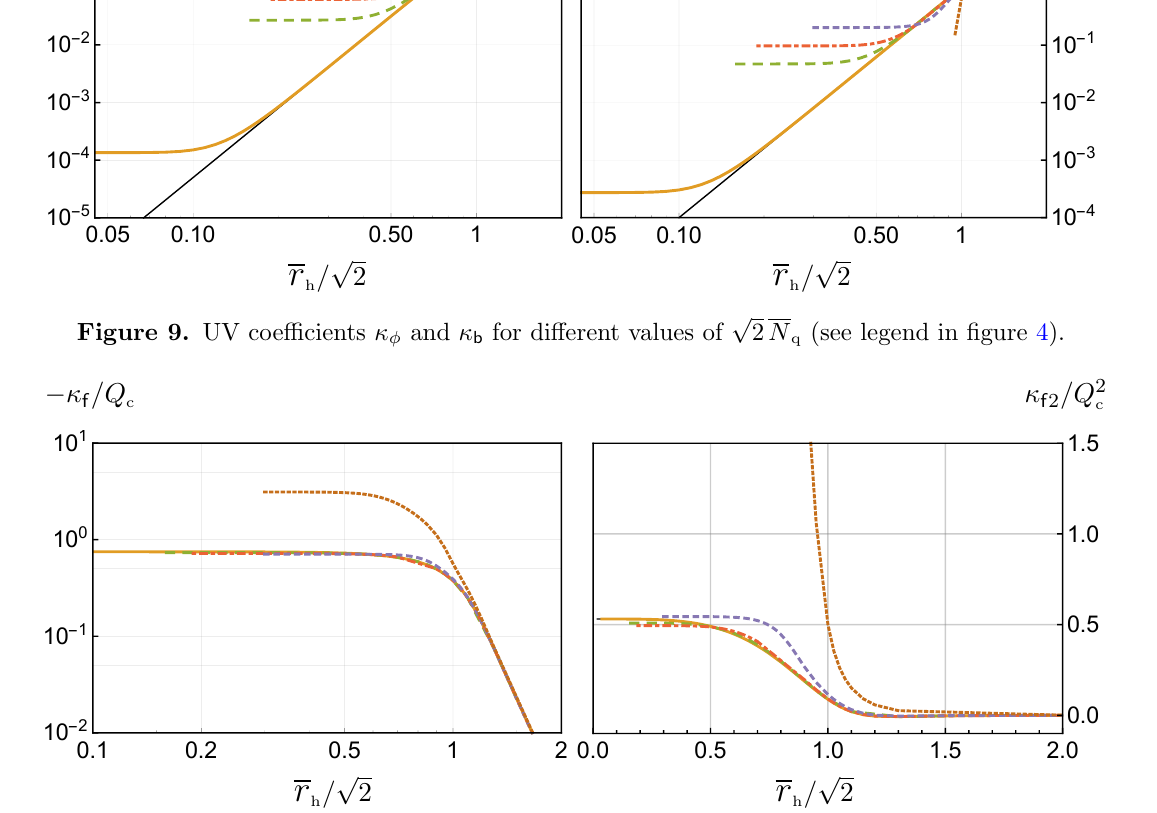
p 2 N (see legend in (cid:12)gure q